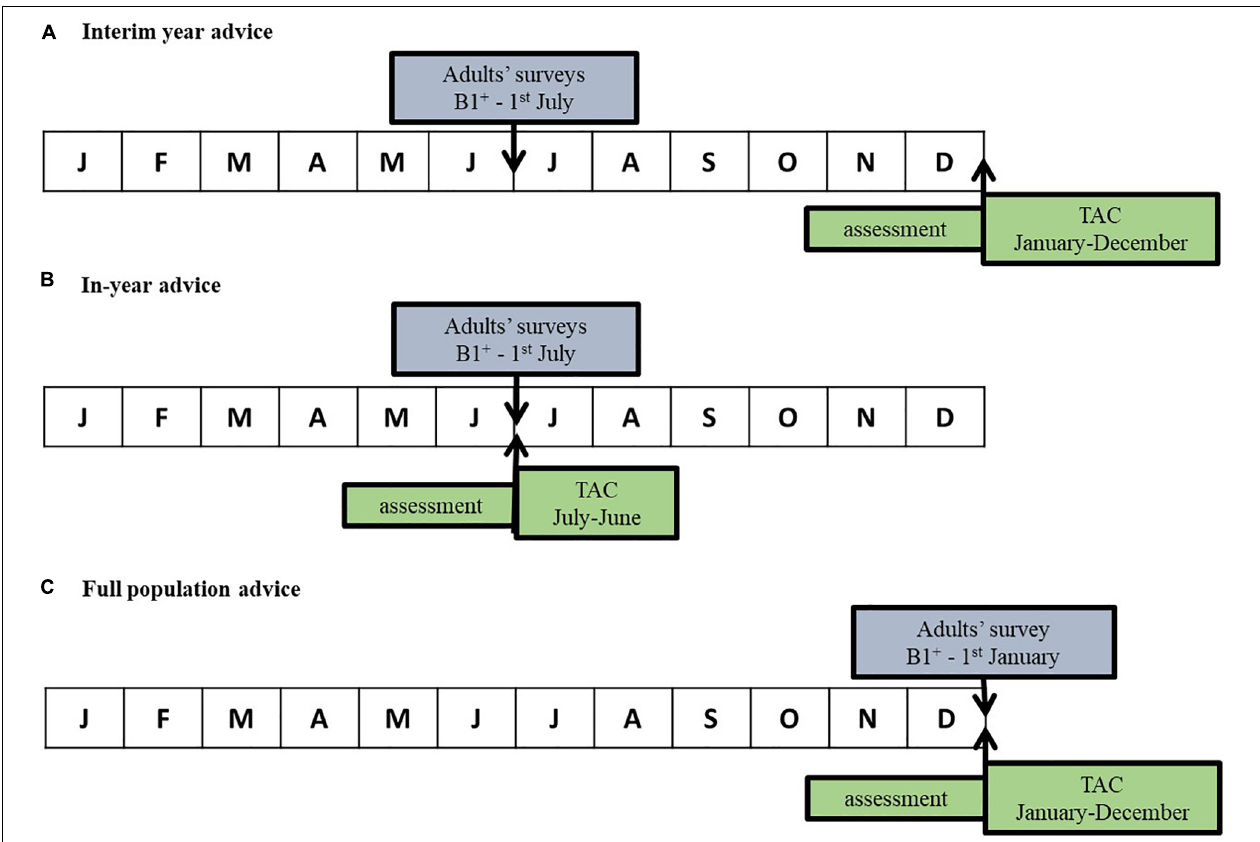
FIGURE 1 | Graphical representation of the timings of abundance surveys, stock assessment and management period for each management calendar. From top to bottom, interim year advice, in-year advice and full population